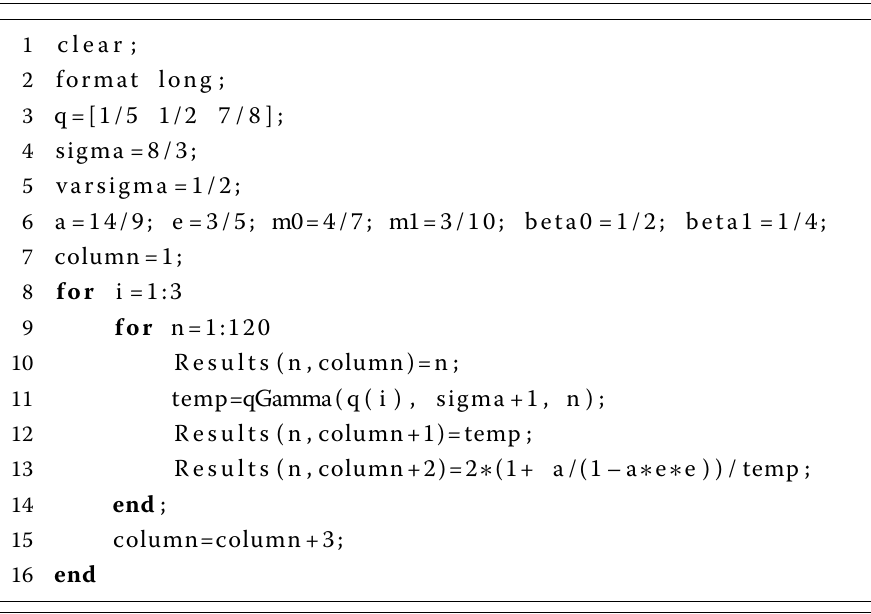
Algorithm 1 MATLAB lines for Examples 4.1 and